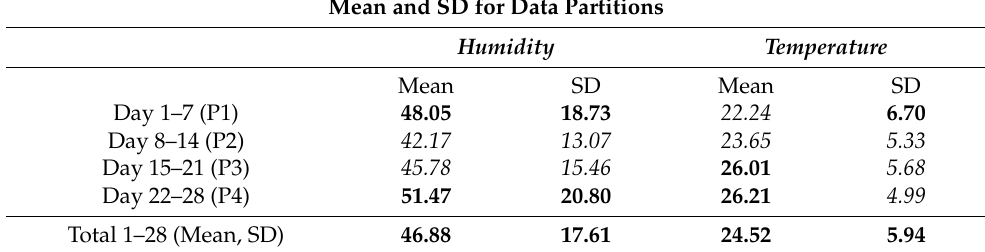
Table 2. Mean and Standard Deviation of fixed partitions P1, P2, P3 and P4 and average over the entire timeseries for Temperature and Humidity ( bold and italic represent values which are higher and lower than the average mean and SD